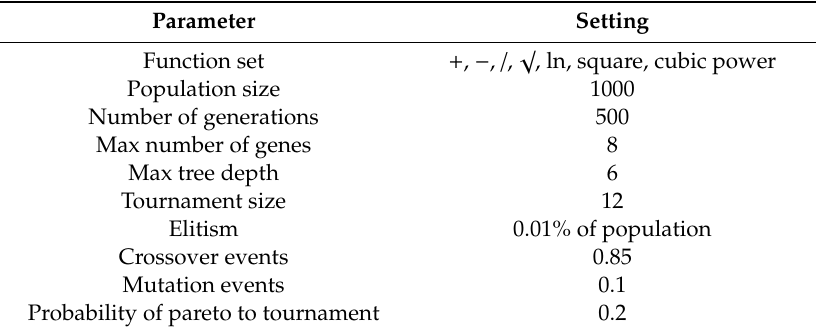
Table 2. Parameter setting for the MGGP